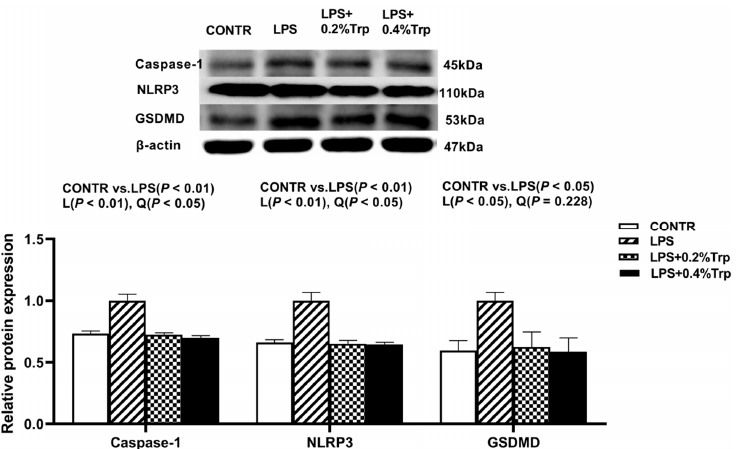
Figure 4. Impact of tryptophan supplementation on the ratios of caspase-1/ β -actin, NLRP3/ β -actin, and GSDMD/ β -actin after 4 h of E. coli LPS challenge in ileal mucosa of weaning piglets. NLRP3, nucleotide-binding oligomerization domain-like receptor protein 3; GSDMD, gasdermin-D CONTR, control; LPS, lipopolysaccharide; Trp, tryptophan. The bands represented Western blot images of caspase-1, NLRP3, and GSDMD. The data are presented as means ± SEM. CONTR vs. LPS was employed to obtain the response to LPS challenge. Linear and quadratic polynomial contrasts were employed to obtain the response of tryptophan supplementation in LPS-challenged piglets. Note: L (linear), Q (quadratic).